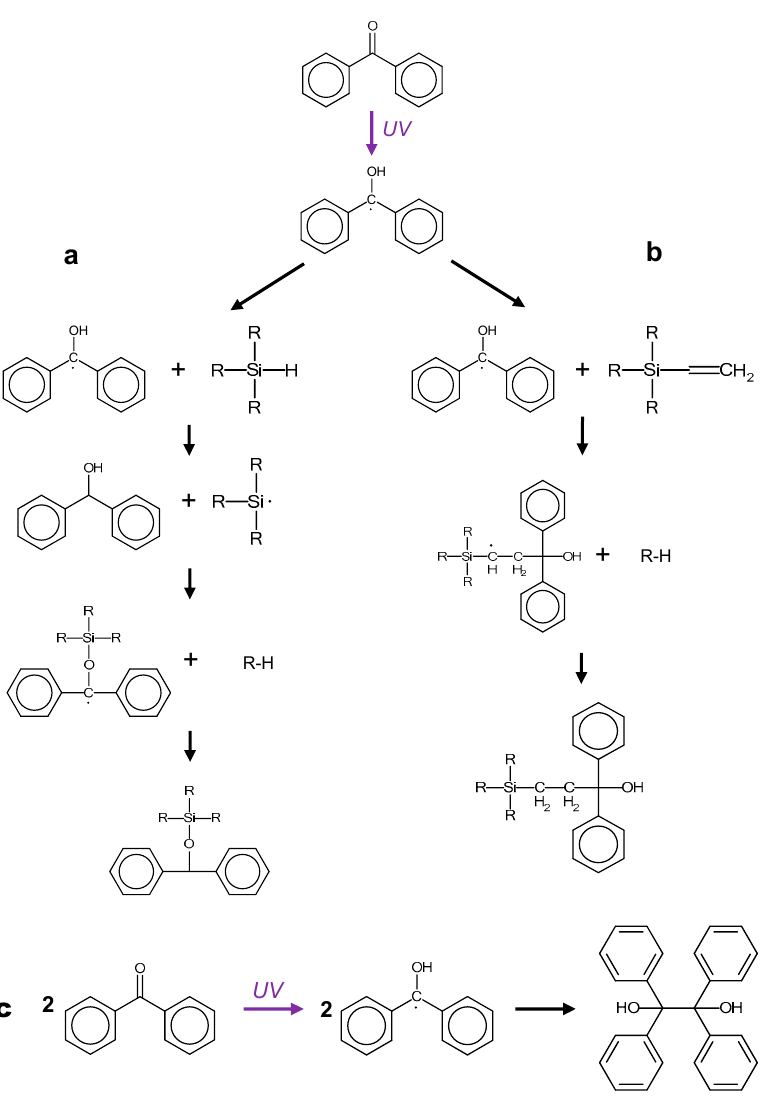
Figure 1. Proposed reactions occurring between UV-excited benzophenone and ( a ) Si-H and ( b ) Si-Vinyl functions [11]. ( c ) Acknowledged photoreaction of benzophenone on itself, forming benzopinacol [4].